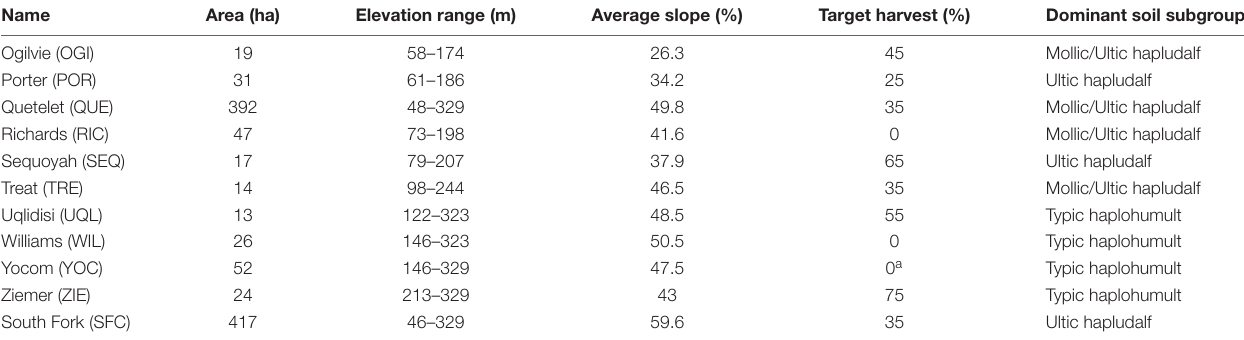
TABLE 1 | Landscape features of the sub-watersheds in the South Fork of Caspar Creek.